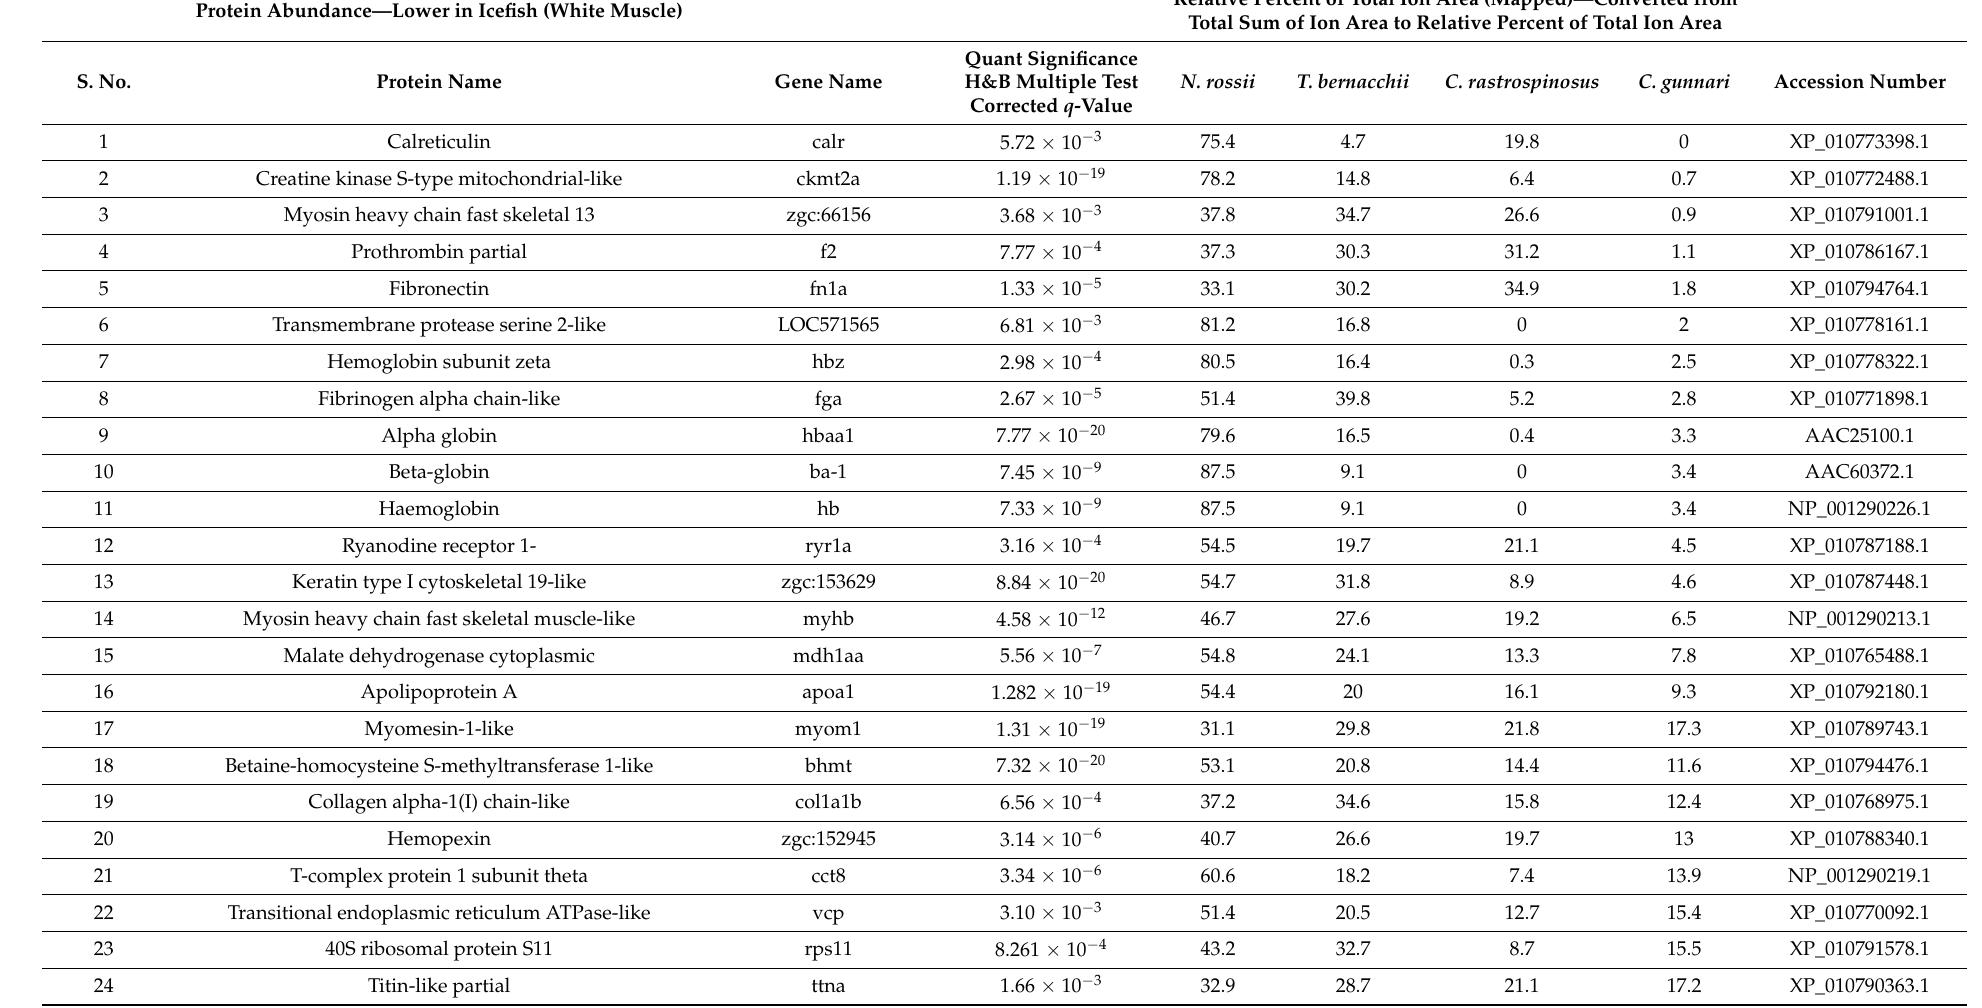
Table 4. DEPs between WMM with decreased abundance in the icefish. Protein Abundance—Lower in Icefish (White